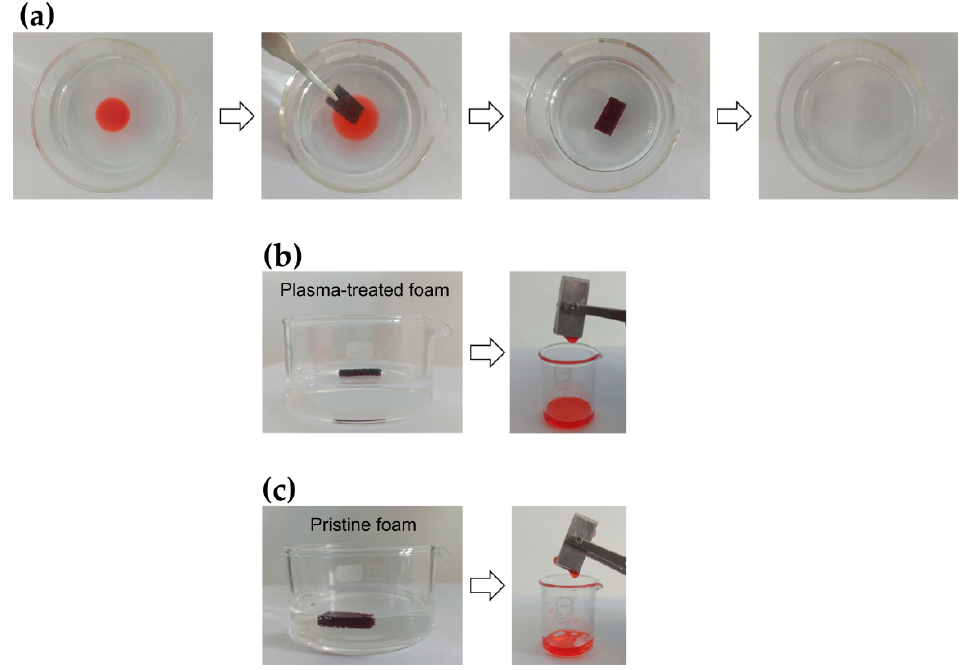
Figure 7. ( a ) Photographs of a typical oil/water separation experiment carried out using a PU foam sample modified by the two-step plasma process optimized in this work (t e/n = 10 min, t d = 10). During the separation experiment, the foam floats on the surface of a light mineral oil/water mixture. The transparent liquid is water, while the red liquid is light mineral oil dyed with Sudan Red III for better visualization. Photographs of the foam samples floating in a beaker containing the light mineral oil/water mixture and of the liquid collected by sample squeezing: ( b ) plasma-treated foam, ( c ) pristine foam.